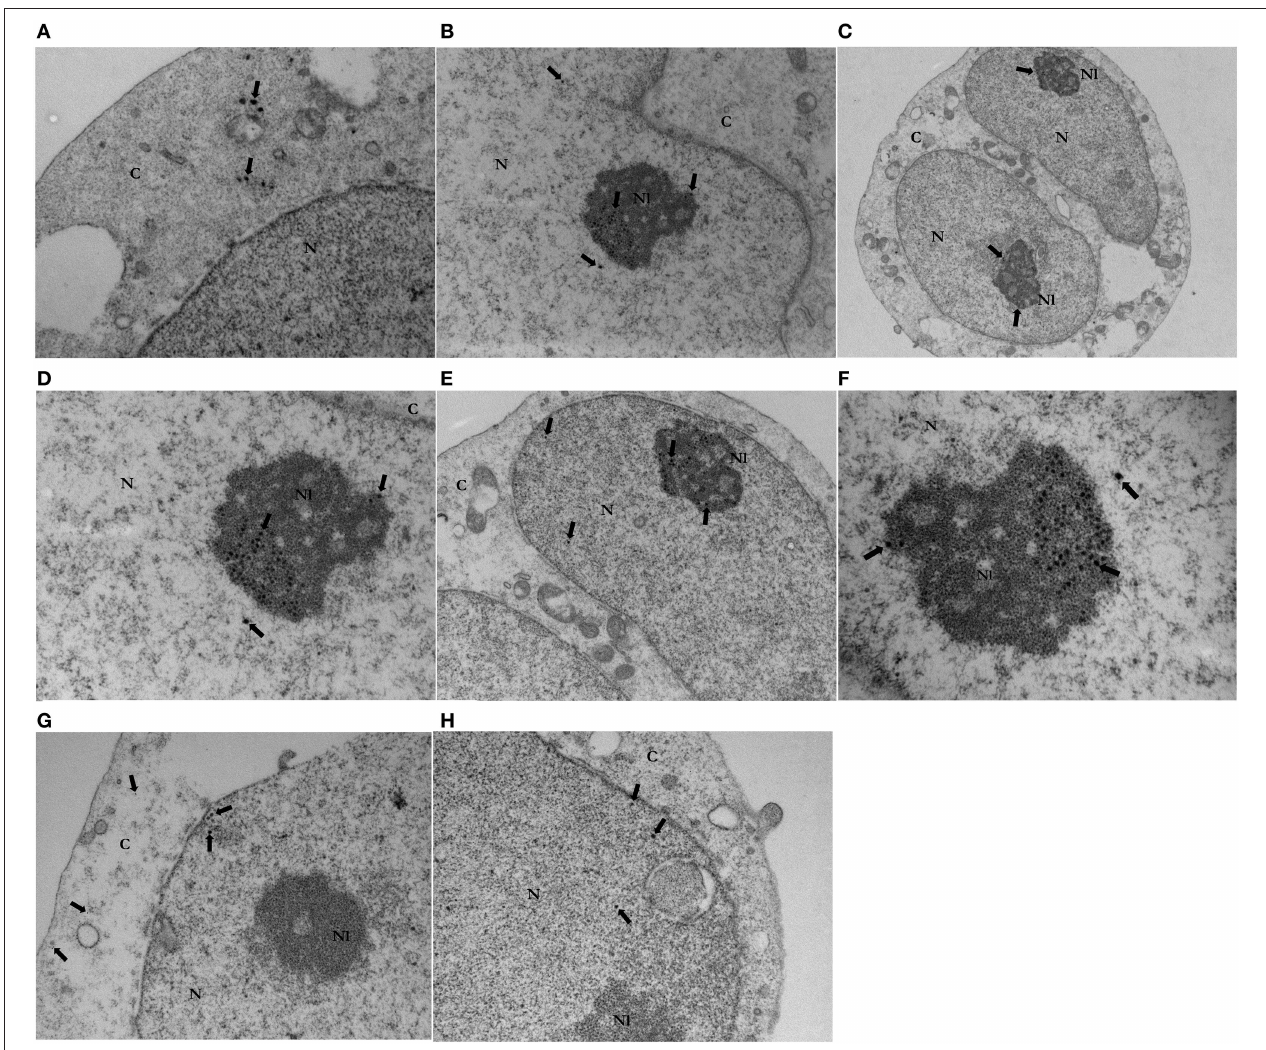
FIGURE 1 | Transmission Electron Microscopy of HCV core-GFP (A–F) or GFP (G,H) transduced Jurkat cells. Images (A) (x20000), (B) (x12000), and (C) (x7000) are representative micrographs from GFP HCV core - expressing Jurkat cells . Gold particles indicate the position of immunolabeled HCV core-GFP inside Jurkat cells. Immunostaining (arrows) revealed GFP HCV core protein in the nucleus [N] (B) , cytoplasm [C] (A) and mainly in the nucleoli [Nl] (B,C) . Micrographs (D) (x20000), (E) (x12000), and (F) (x30000) show a magnification of the gold labeled HCV core-GFP expressing Jurkat cell. This closer inspection confirmed gold particles labeling GFP core protein (arrows) in the nucleus, with enrichment and a clustering distribution in the nucleoli. Images (G) (x20000) and (H) (x20000) are representative micrographs of GFP-expressing control Jurkat cells . Gold particles indicate the position of immunolabeled GFP. Immunostaining (arrows) revealed GFP in the cytoplasm (G) and nucleus (G,H) . No immunostaining was observed in the nucleoli in GFP control cells (G,H) .